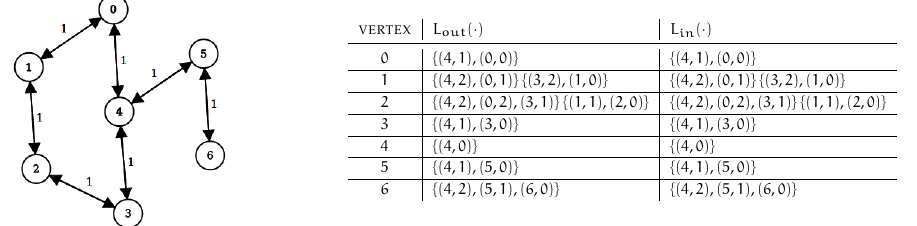
Figure 4. Consider again the graph of Figure 1 and a corresponding 2- HOP - COVER labeling. Assume arc ( 4 , 0 ) is removed. We have that vertex 3 is in F L G ( 0 , 1 ) and vertex 0 is in B L G ( 0 , 1 ) . However, there is no outdated label entry in L out ( 3 ) but the decremental operation on arc ( 4 , 0 ) causes the cover property to be broken for pair ( 3 , 0 )